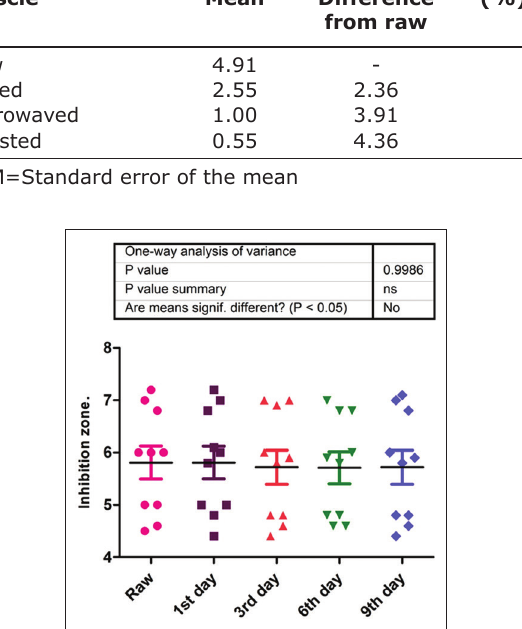
Table-4: Comparison of inhibition zones between raw Liver and different cooking methods at pH 7.2. Muscle Mean